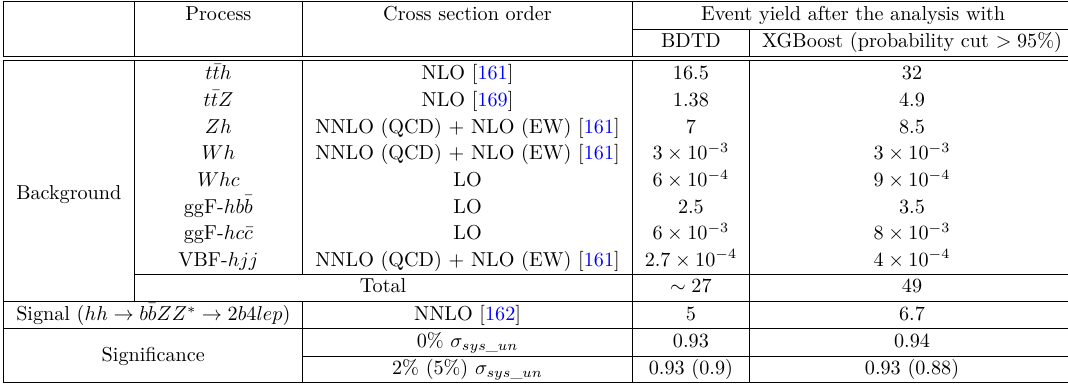
Table 7 . The signal and background yields at the HE-LHC along with the signal significance for the b ¯ bZZ ∗ → 2 b 4 l 0 channel from the analysis using the BDTD and the XGBoost classifiers.